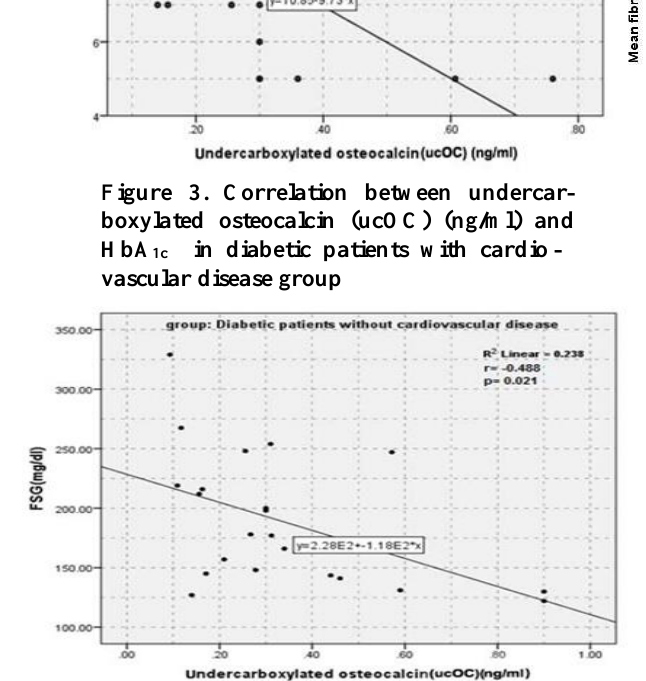
Figure 4. Correlation between undercar - boxylated osteocalcin (ucOC) (ng/ml) and fasting serum glucose (FSG) (mg/dl) in diabetic patients without cardiovascular disease group.